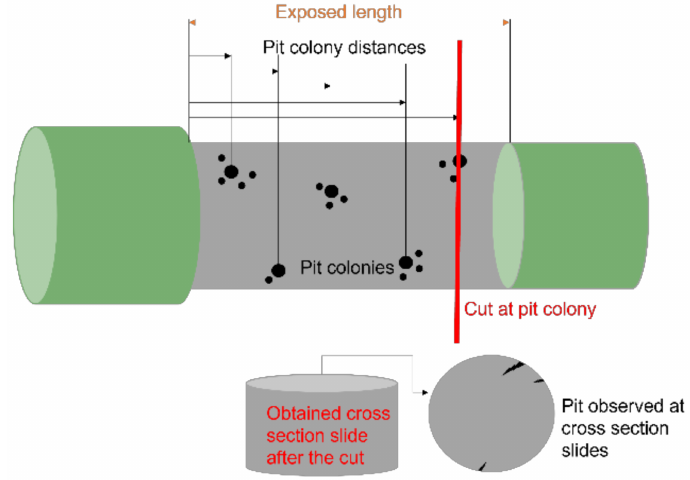
Figure 2. Schematic description of surface characterization